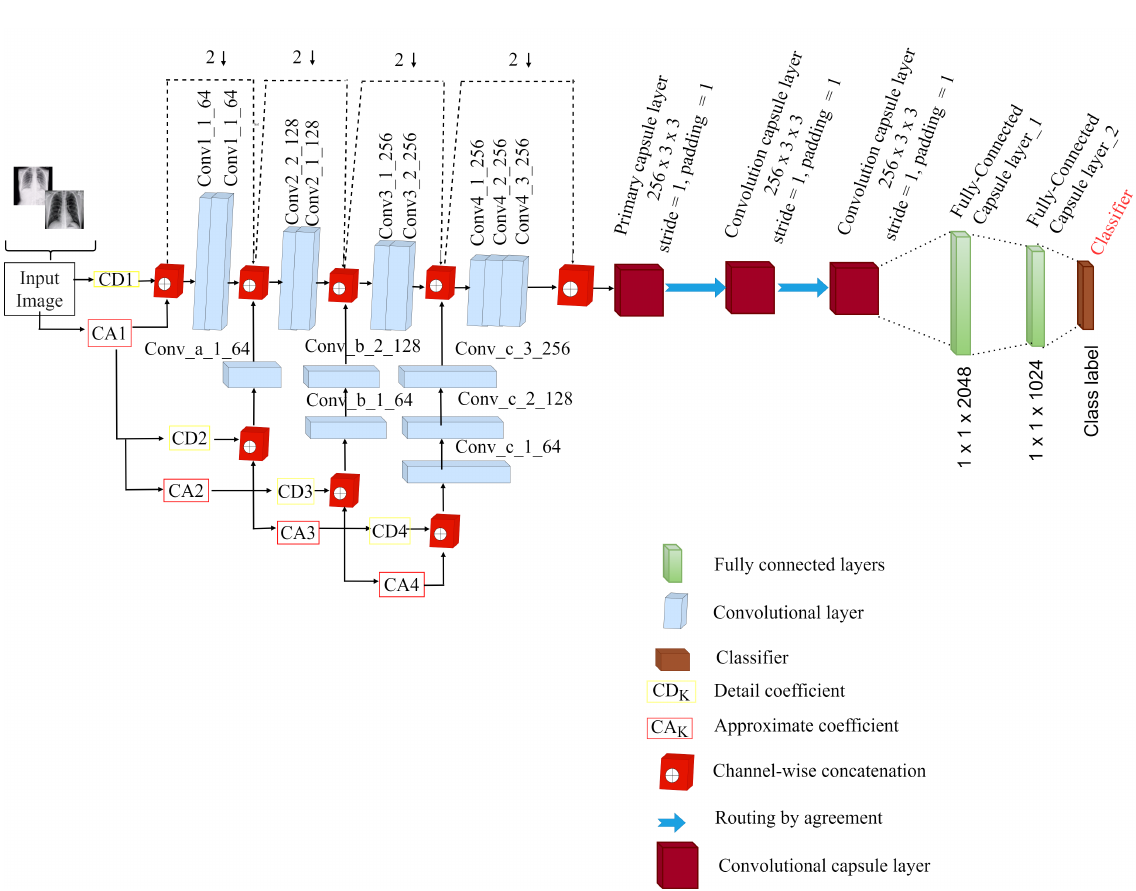
Figure 1. Our proposed neurowavelet capsule network for COVID-19 classification